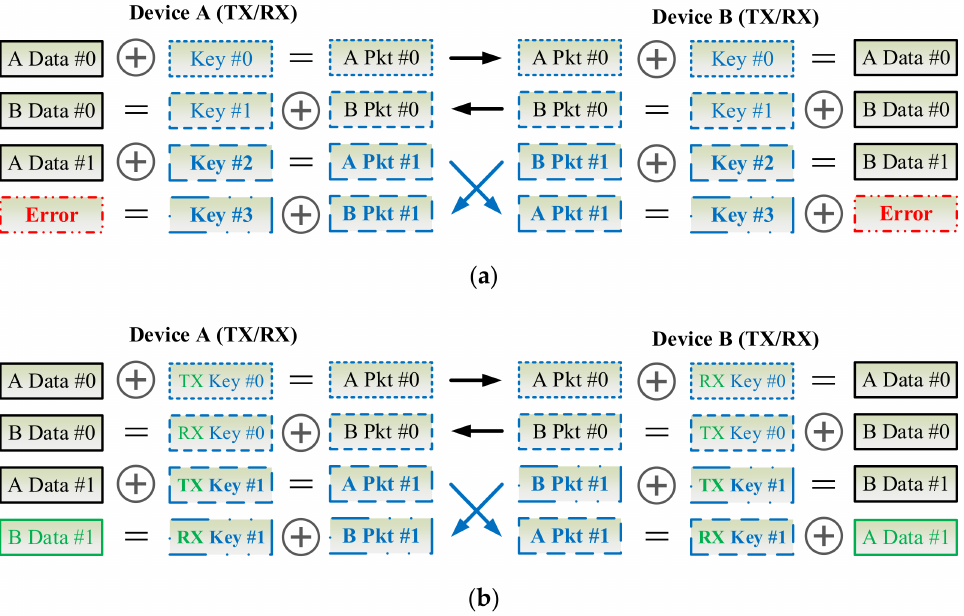
Figure 11. Scenarios where packets transmitted simultaneously from both devices ( a ) cause a key synchronization problem or ( b ) are patched by a basic solution to separate the keys used for TX and